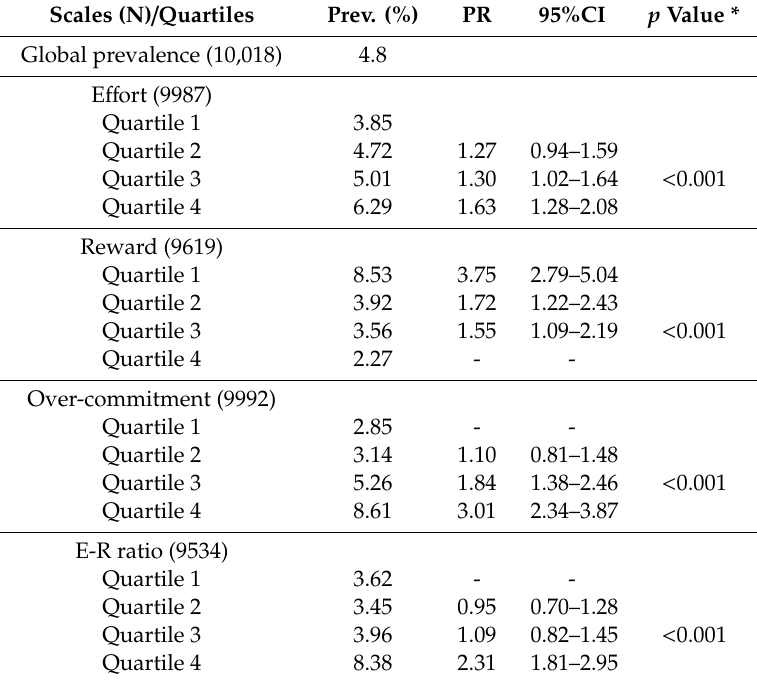
Table 2. Prevalence of depressive episodes (%) and crude associations of the ERI scales with depressive episodes. ELSA-Brasil Study,